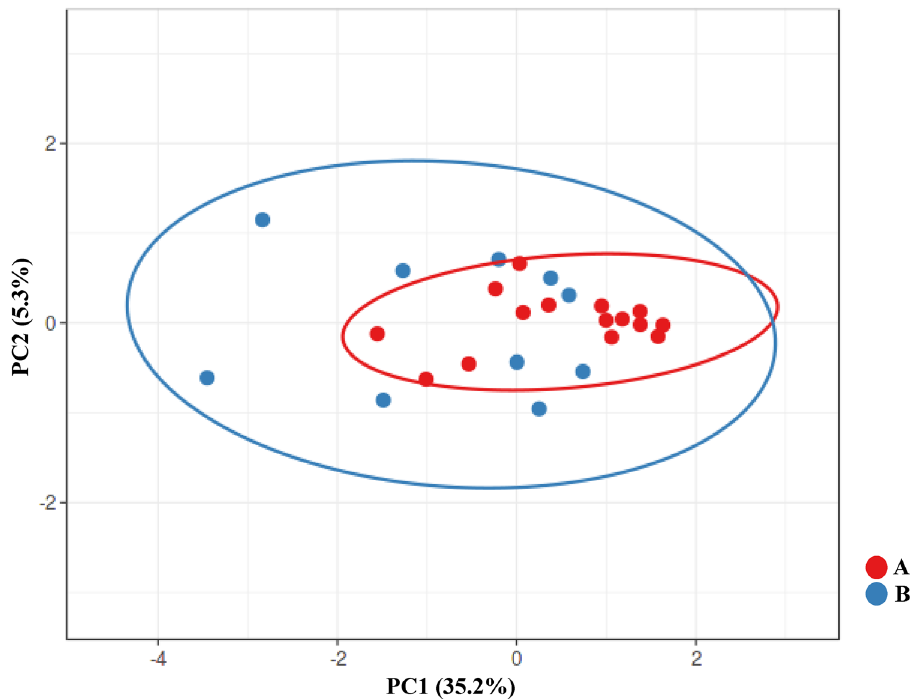
Figure 4. PCA analysis of all growth parameters of wheat, maize, and canola treated by isolates collected from locations A (silt) and B